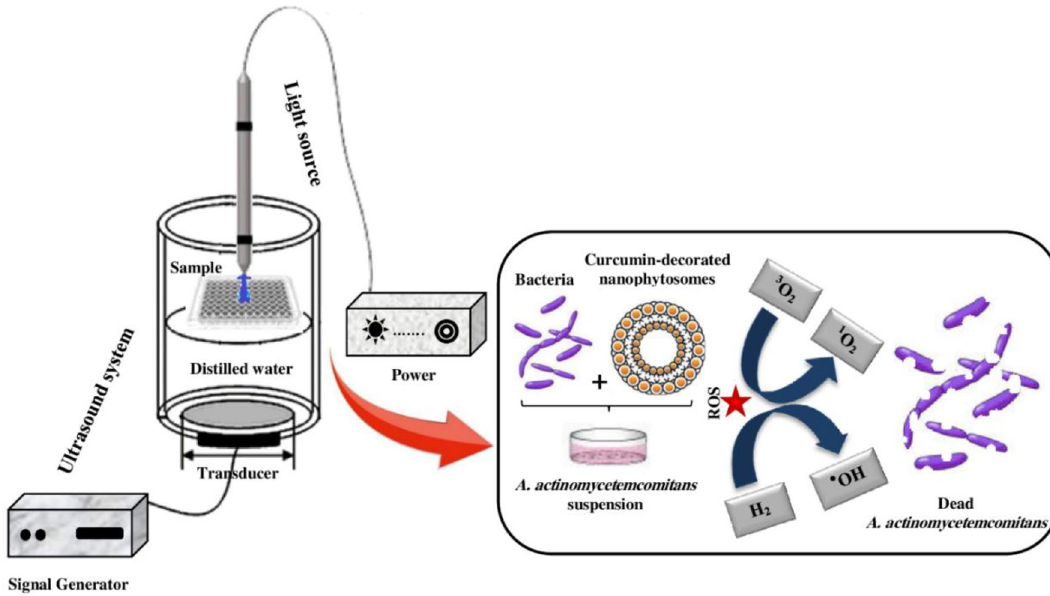
Figure 11. Schematic apparatus for illumination treatment of